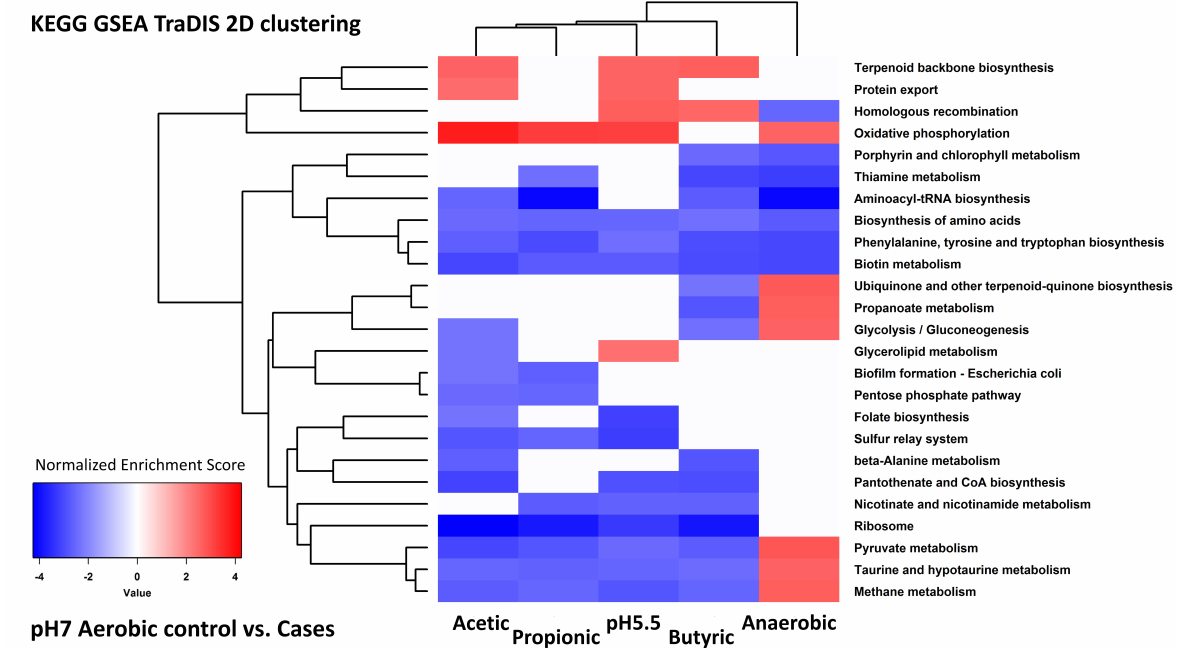
Figure 6. Clustering of KEGG pathways identified by GSEA analysis of TraDIS data. An example is shown of this analysis for all aerobic cultures at pH 7. All four conditions are shown in Figure